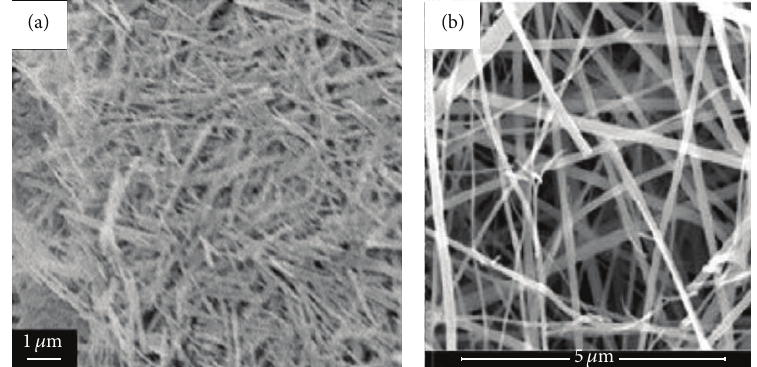
Figure 7: (a) FESEM of TiO 2 nanowires synthesized via a hydrothermal process [5], (b) FESEM of TiO 2 nanowires synthesized via an electrospun process